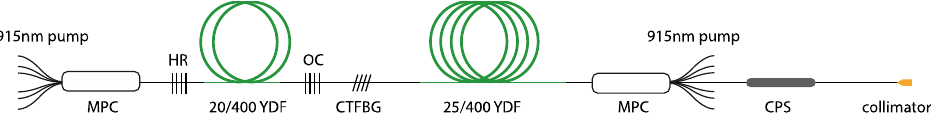
Figure 3. The optical construction of the fiber laser. MPC: multimode power combiner; HR: high reflector; OC: output coupler; YDF: ytterbium-doped fiber; CTFBG: chirped and tilted fiber Bragg grating; CPS: cladding power stripper.